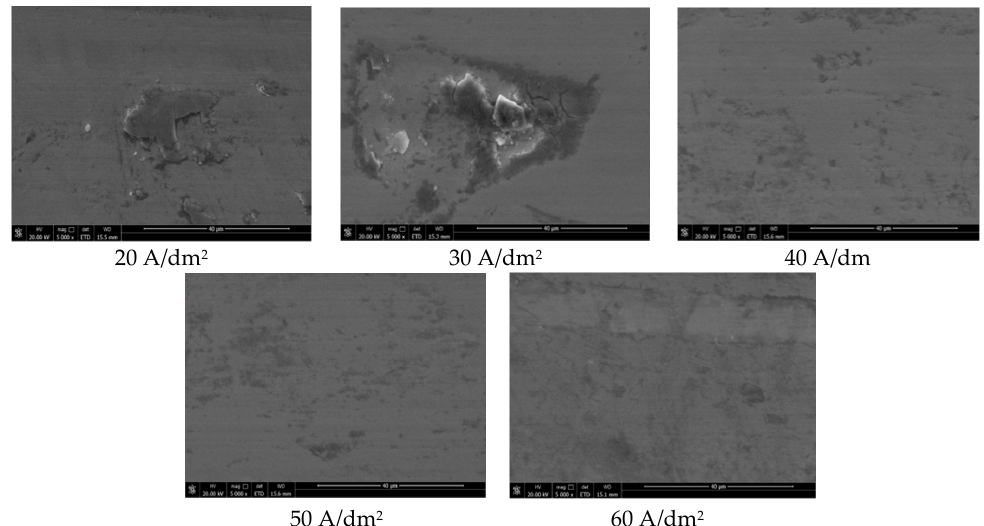
Figure 9. SEM images of wear scars on composite coatings prepared at different current densities after friction tests. friction